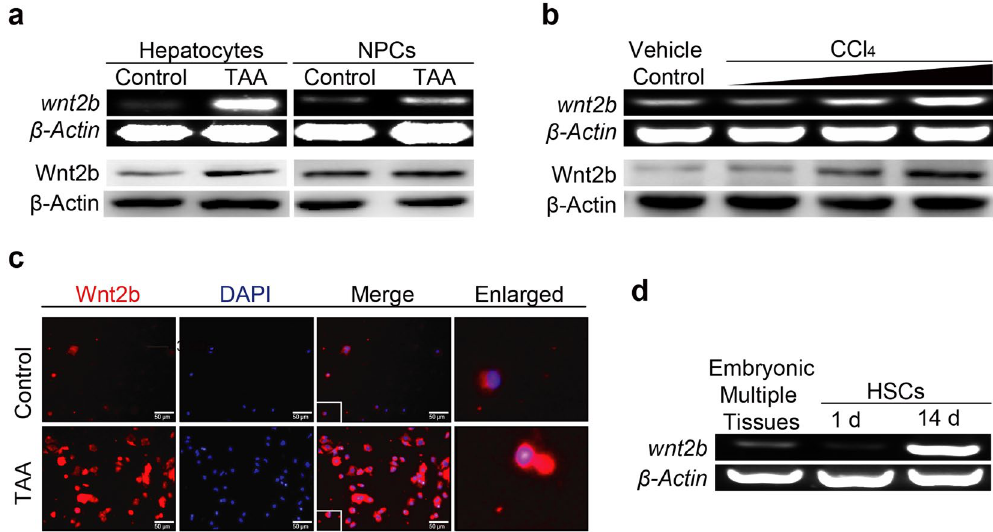
Figure 2. Wnt2b is mainly produced by hepatocytes during liver fibrogenesis. ( a ) mRNA and protein levels of Wnt2b in hepatocytes (left) and NPCs (right) from control and TAA-treated mice, respectively. ( b ) mRNA (upper) and protein (lower) levels of Wnt2b in primary mouse hepatocytes treated with CCl 4 in vitro . ( c ) Immunofluorescence staining of Wnt2b in HSCs from control and TAA-treated mice. ( d ) RT-PCR analysis of Wnt2b in cultured HSCs from naive mice at the indicated points of time. Mouse embryonic tissues served as positive controls. Cropped blots are displayed; Full-length blots are presented in Supplementary Fig. S5. Data are mean ± SEM of three independent experiments; * P < 0.05, ** P < 0.01, *** P <